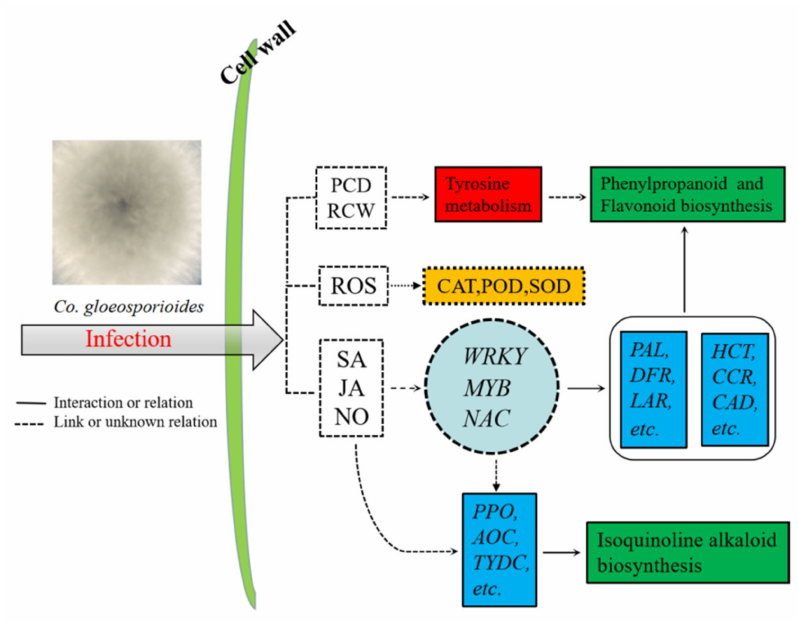
Figure 9. A schematic diagram of the defense response of Ca. oleifera to the anthracnose